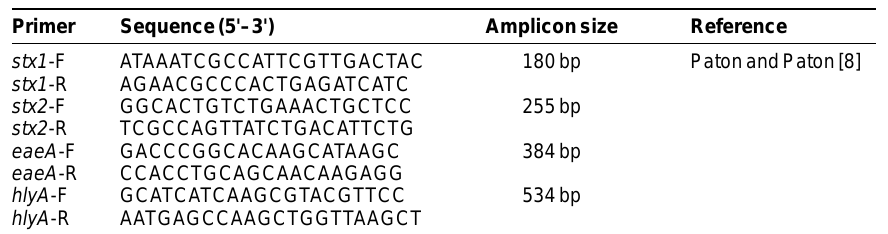
Table-1. List of primers (5'-3') used in the mPCR